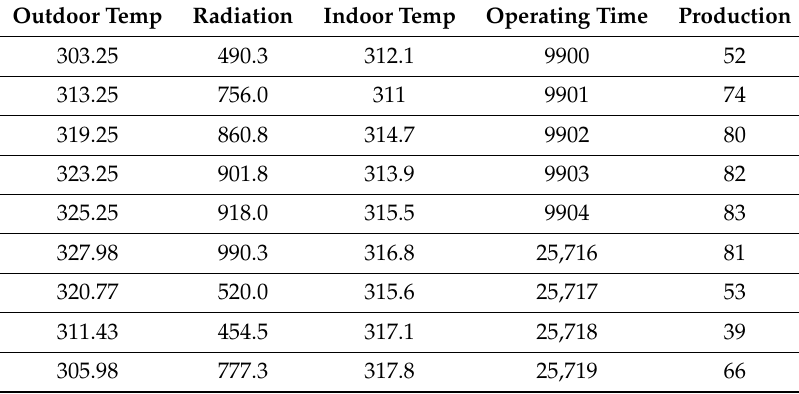
Table 4. Collected data in the study (treated and